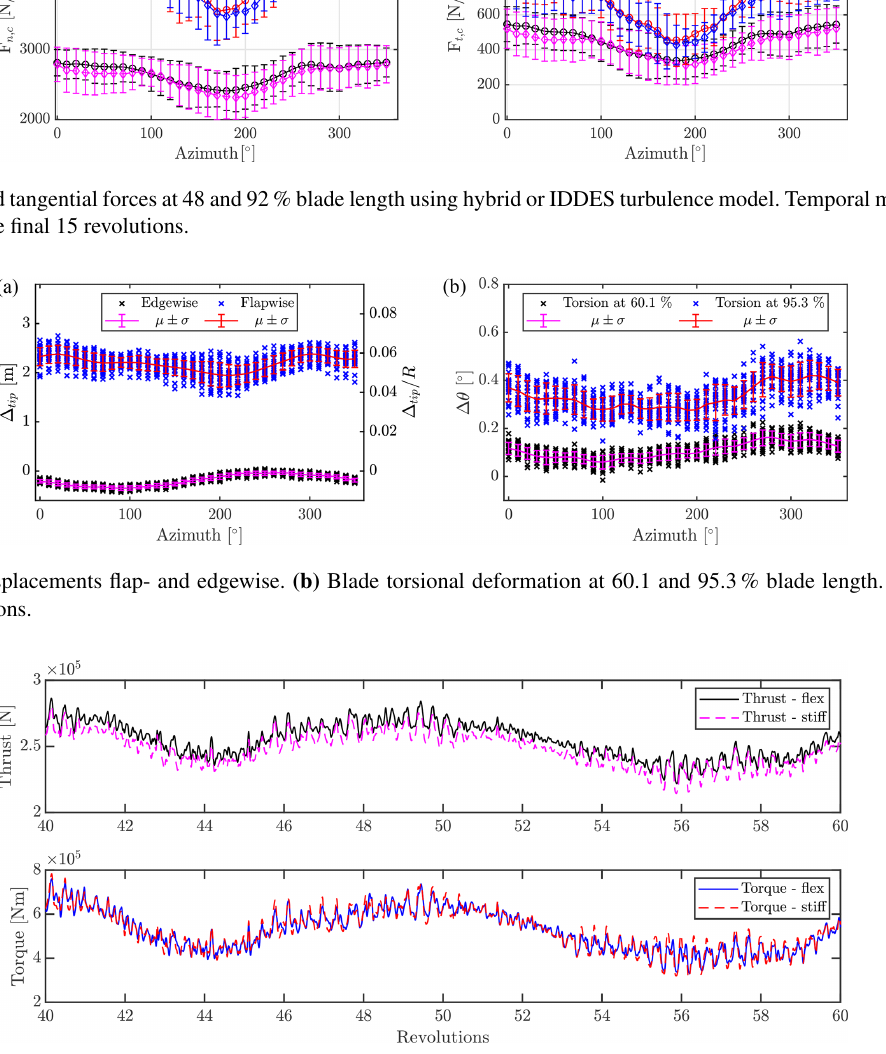
Figure 15. Integrated thrust and torque for stiff and flexible